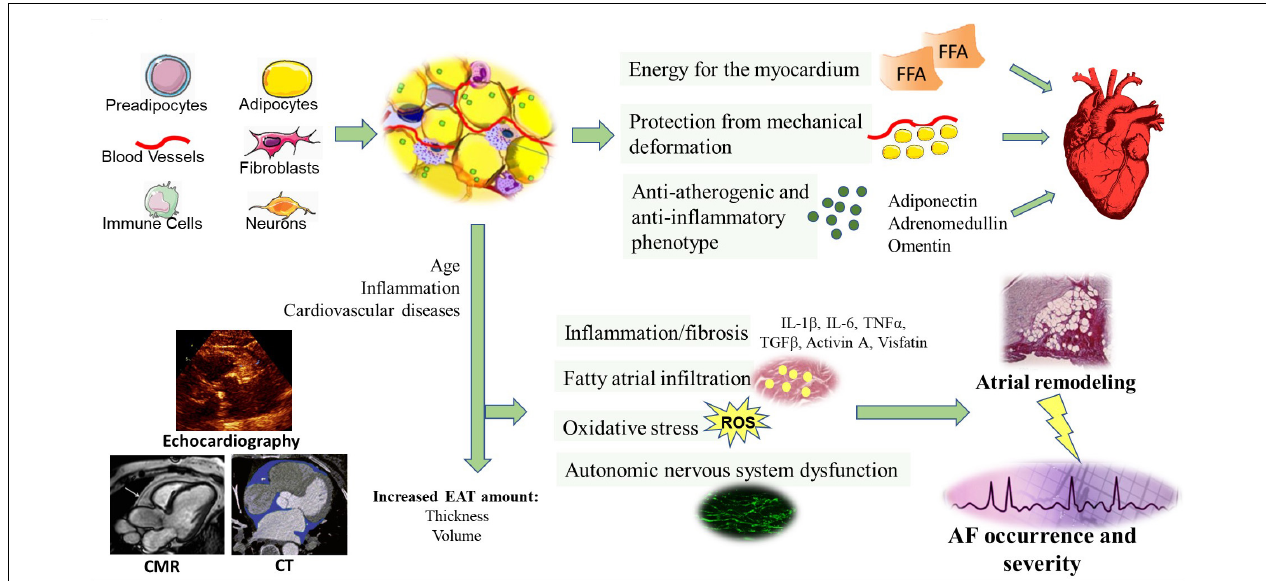
FIGURE 1 | EAT tissue structure and its pathological switch from a protective anti-inflammatory and anti-atherogenic phenotype to a pro-inflammatory, pro-fibrotic, and pro-adrenergic one. EAT potentially contributes to the development of AF through several arrhythmogenic mechanisms, including fatty atrial infiltration, secretion of pro-inflammatory and pro-fibrotic mediators, oxidative stress, autonomic nervous system dysfunction. EAT measurement can be obtained through different imaging methods, such as echocardiography, CT and